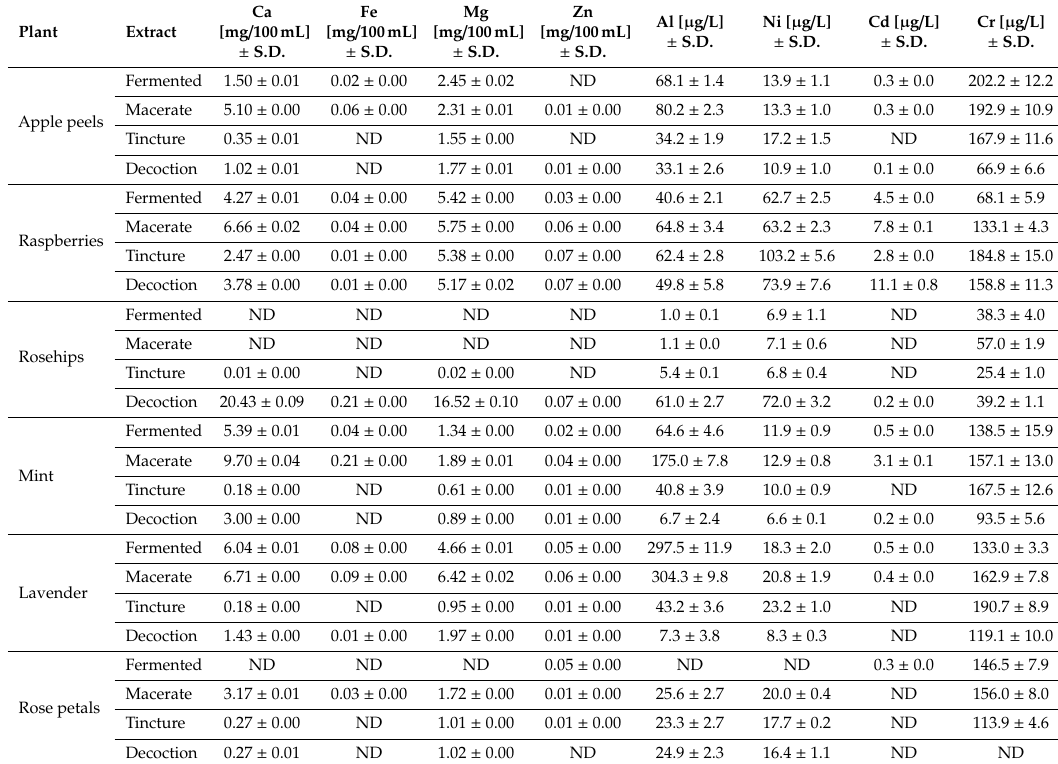
Table 3. Metal concentrations in fruit and herbal extracts analyzed using inductively coupled plasma mass spectrometry